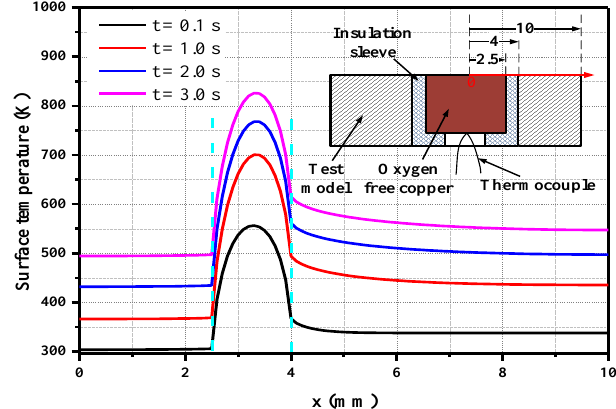
Figure 18. Surface temperature distributions of the copper calorimeter at different test times.